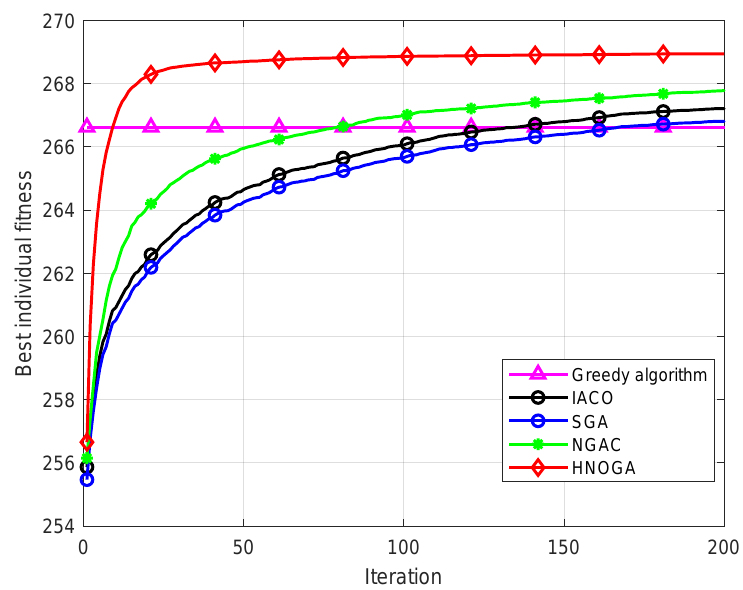
Figure 5. Performance simulation experimental curve of HNOGA algorithm.